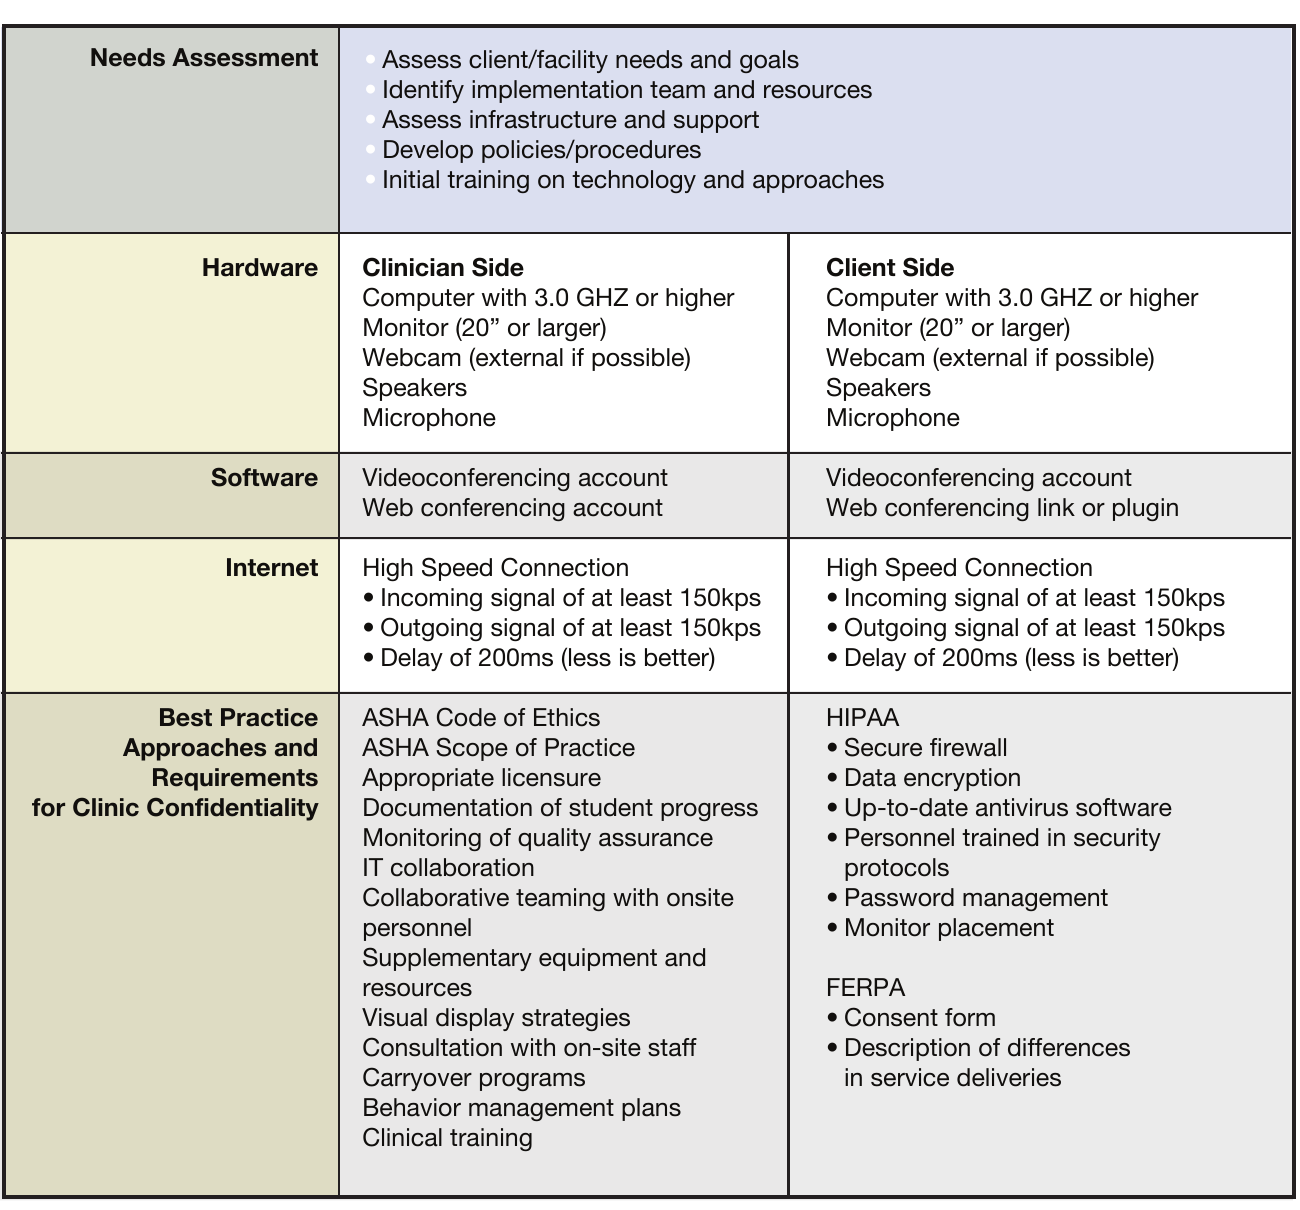
Direct Telepractice